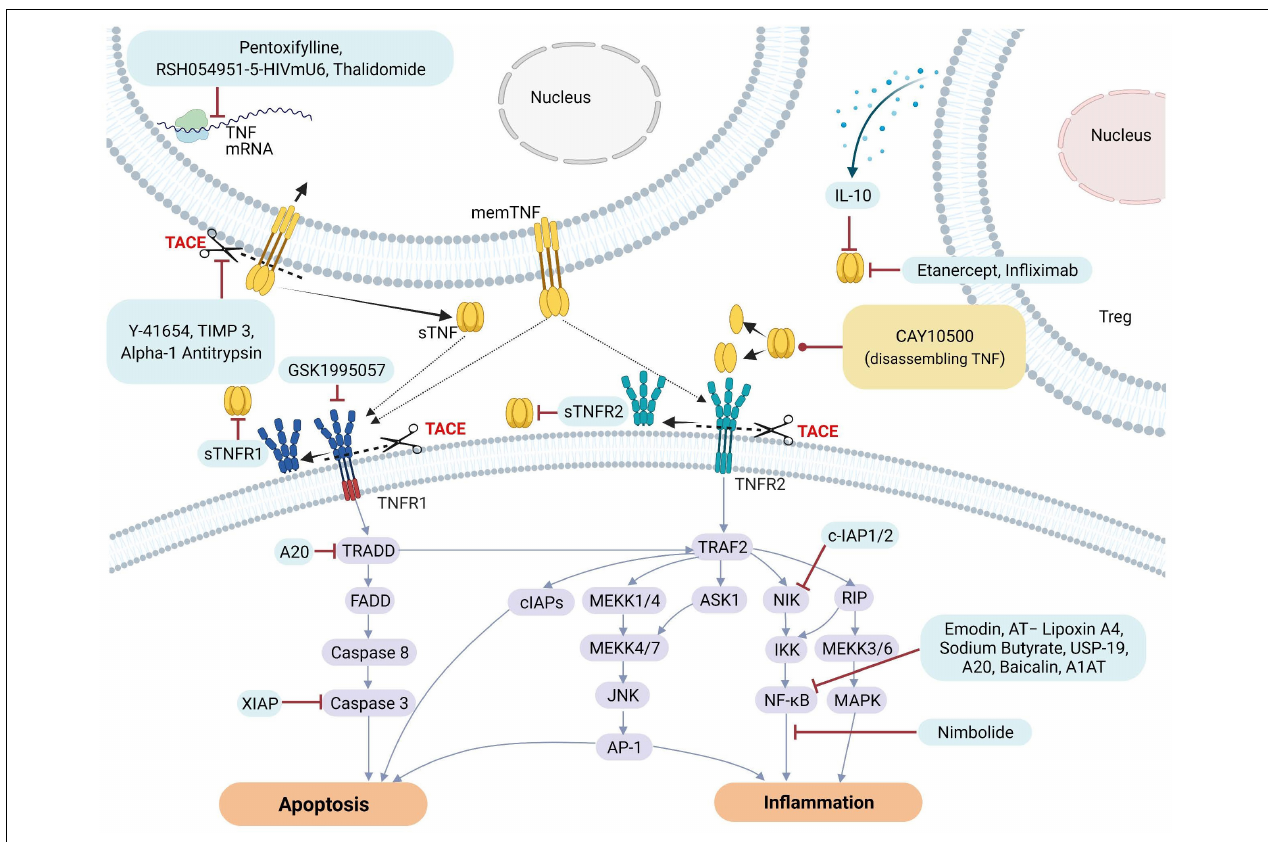
FIGURE 3 | Natural and pharmacological inhibitors of TNF and TNF receptor expression and bioactivity. AP-1, Activator protein 1; AQP5, Aquaporin 5; ASK1, Apoptosis signal-regulating kinase 1; ASM, acid sphingomyelinase; cIAP1, Cellular Inhibitor of Apoptosis Protein 1; ENaC, epithelial sodium channel; FADD, Fas-associated protein with death domain; ICAM-1, intercellular adhesion molecule-1; IL, Interleukin; JNK, c-Jun NH2-terminal kinase; MAPK, mitogen-activated protein kinase; MEKK, mitogen-activated protein Kinase/ERK kinase kinase; mRNA, messenger RNA; NF- κ B, Nuclear factor kappa B; NIK, NF- κ B-inducing kinase; sTNF, soluble TNF; TACE, TNF converting enzyme; TJs, tight junctions; TNF, tumor necrosis factor; TNFR1, TNF receptor 1; TNFR2, TNF receptor 2; TRAF2, TNF receptor-associated factor 2; TRADD, TNFRSF1A Associated via death domain; XIAP, X-Linked inhibitor of